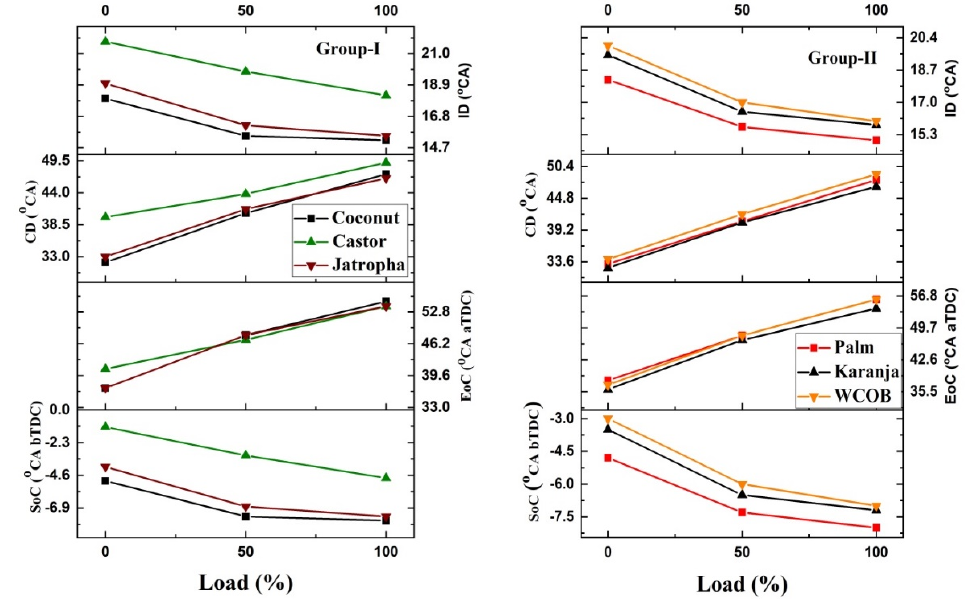
Figure 3. Combustion characteristics for group I and group II saturated fatty acid methyl esters.